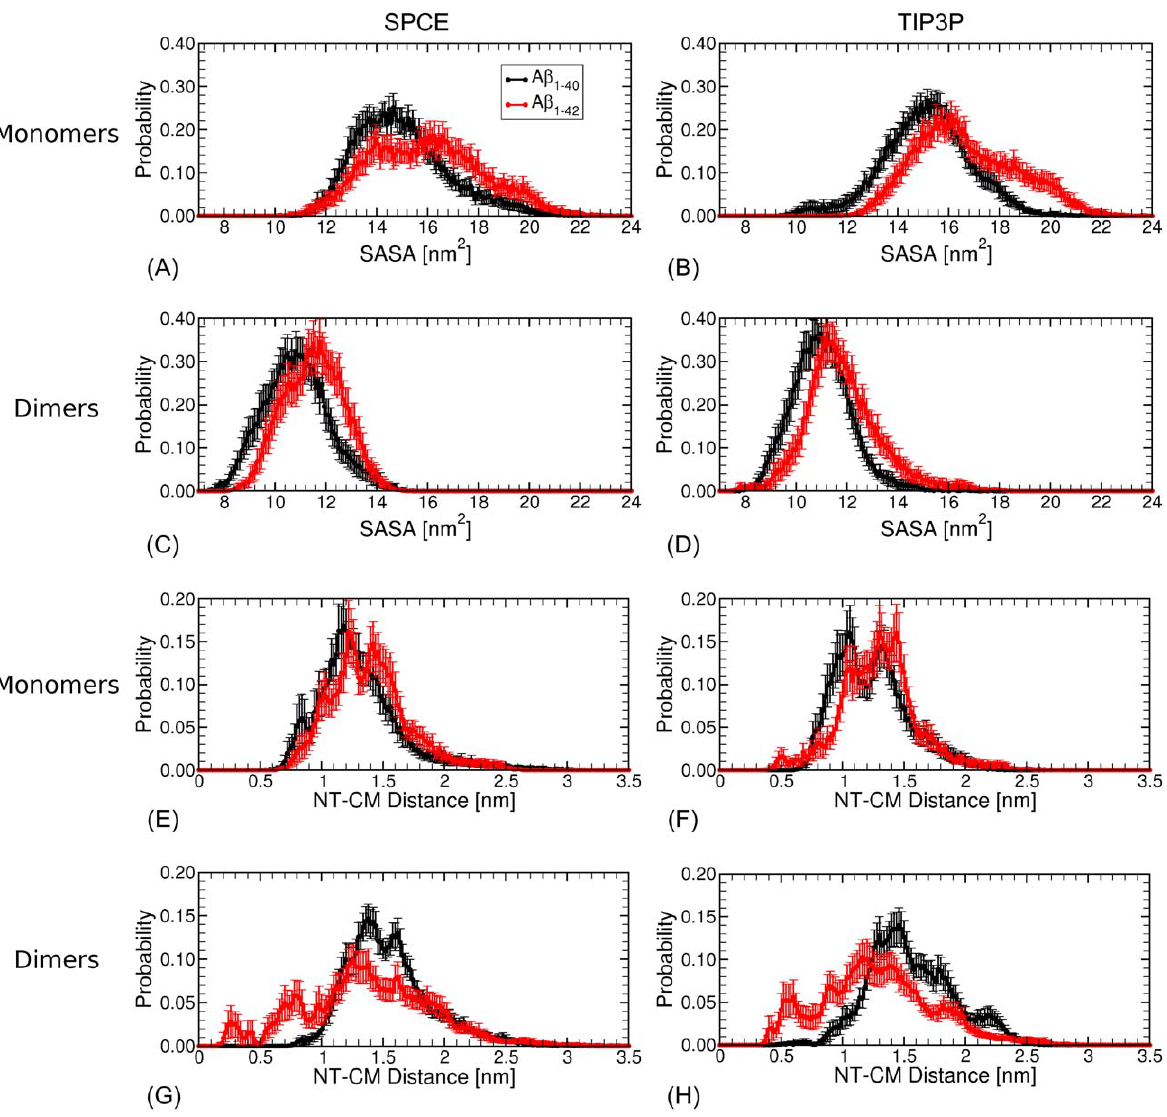
Figure 4. Probability distributions of SASA values and NT-CM values in MD-derived fully atomistic A b 1 { 40 and A b 1 { 42 monomers and dimers. The SASA value was calculated as a sum of SASA values over all hydrophobic residues for each monomer and dimer conformation. Similarly, the NT-CM distance was calculated for each monomer and dimer conformation. The resulting histograms were normalized to obtain probability distributions, displayed as black curves for A b 1 { 40 and red curves for A b 1 { 42 monomers and dimers for each of the two water models. The error bars represent SEM values.